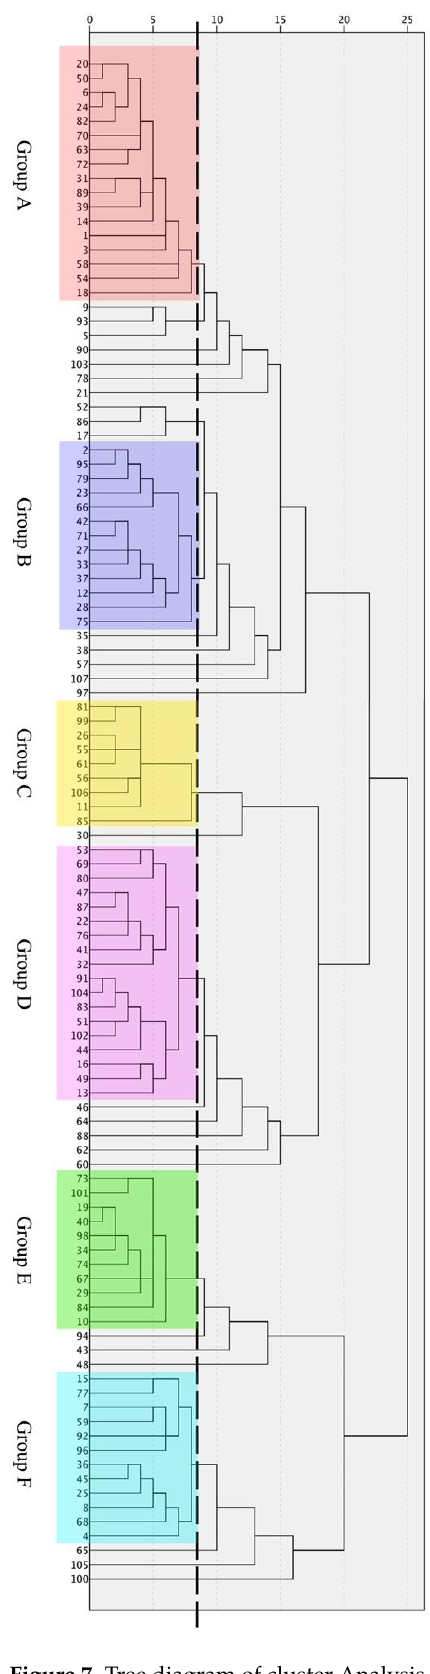
Figure 7. Tree diagram of cluster Analysis.